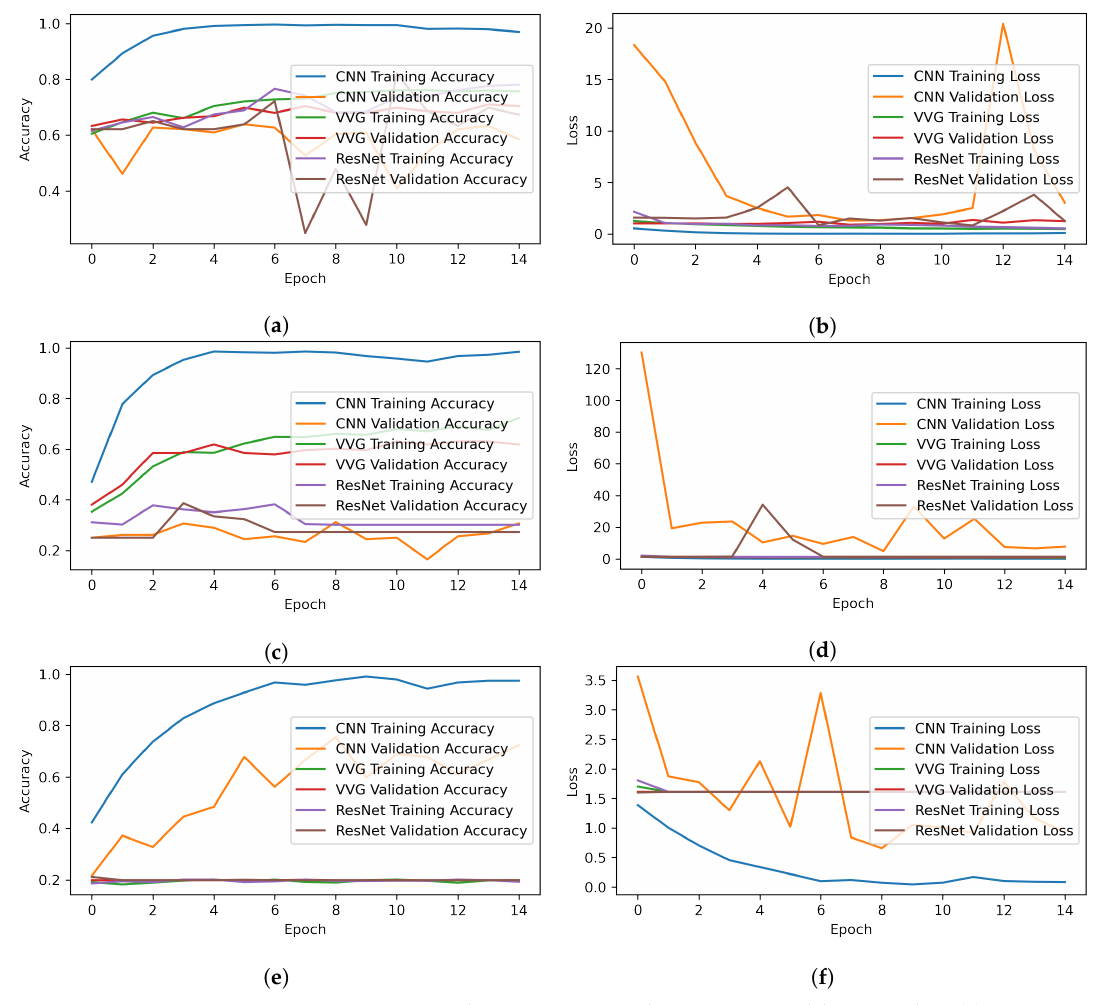
Figure 10. Training and testing per epochs accuracy and loss graphs. ( a ) Accuracy on original dataset, ( b ) Loss on original dataset, ( c ) Accuracy on augmented dataset, ( d ) Loss on augmented dataset, ( e ) Accuracy on over-sampled dataset, and ( f ) Loss on over-sampled dataset. Table 12. Deep learning models performances with each